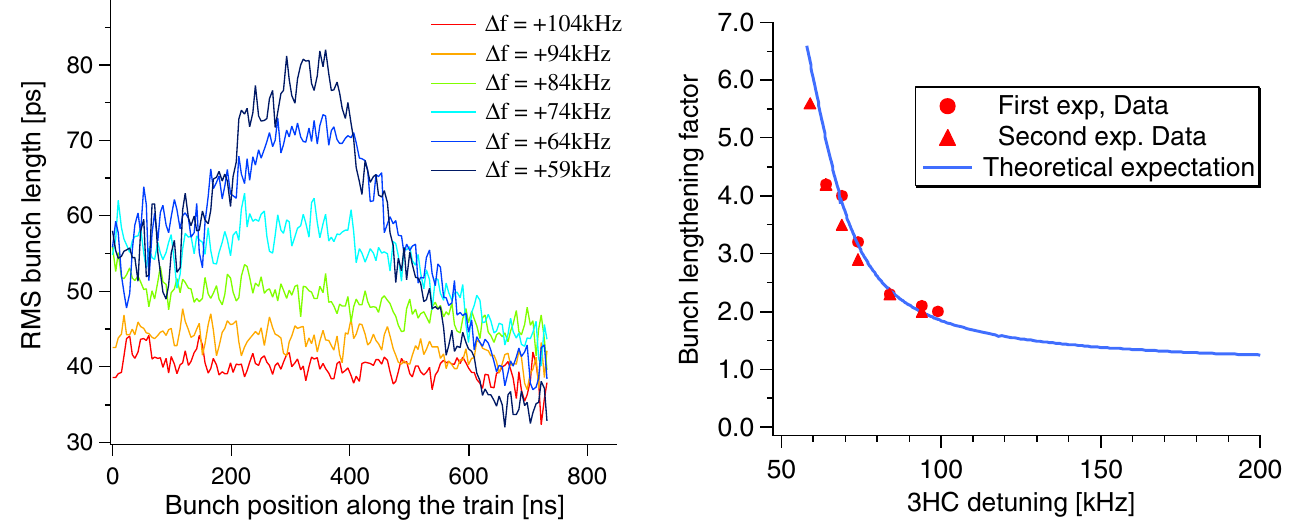
FIG. 12. (Color) Comparison between two set of experimental (cid:1) 315 mA , E (cid:1) data, obtained in the same machine condition, and theoretical beam calculation for a uniform filling pattern, at 315 mA, 2.0